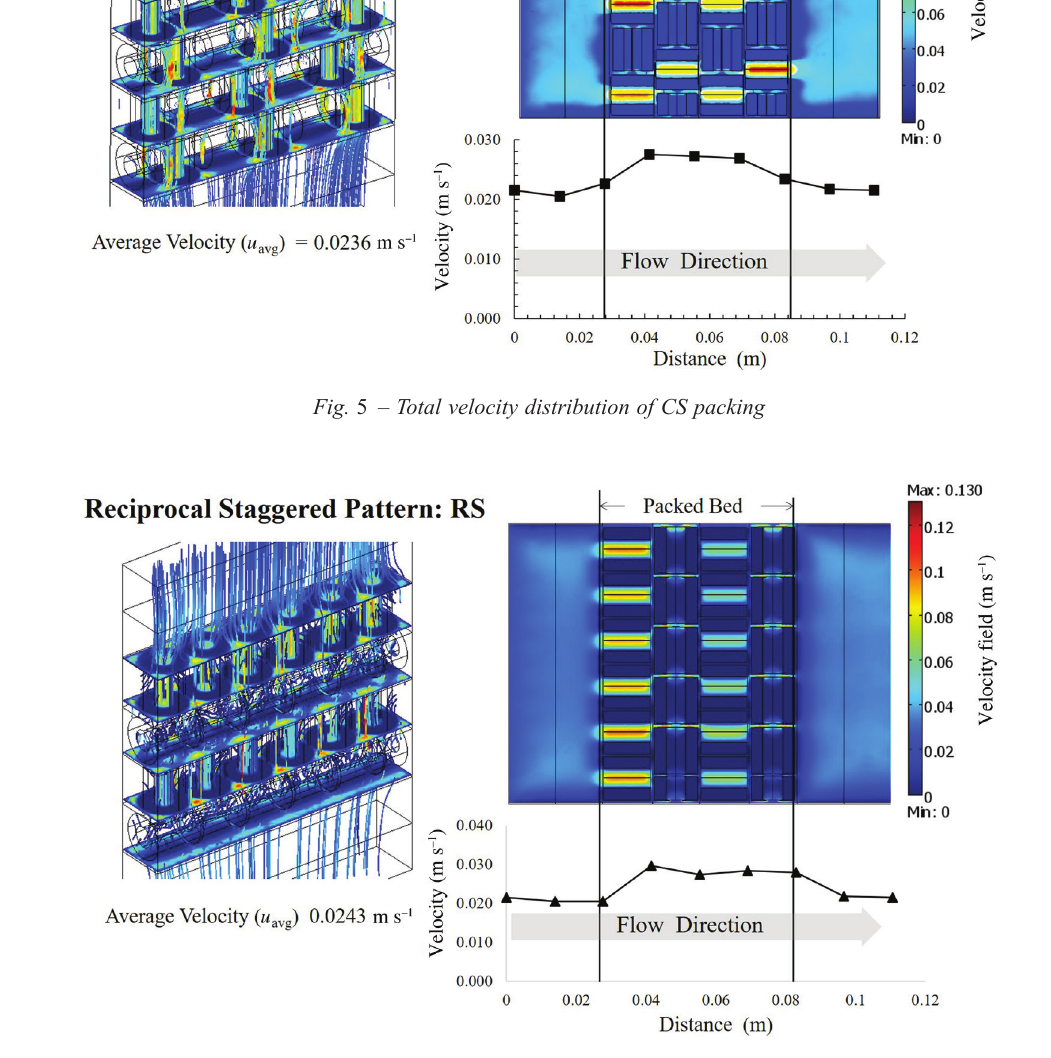
Fig. 6 – Total velocity distribution of RS